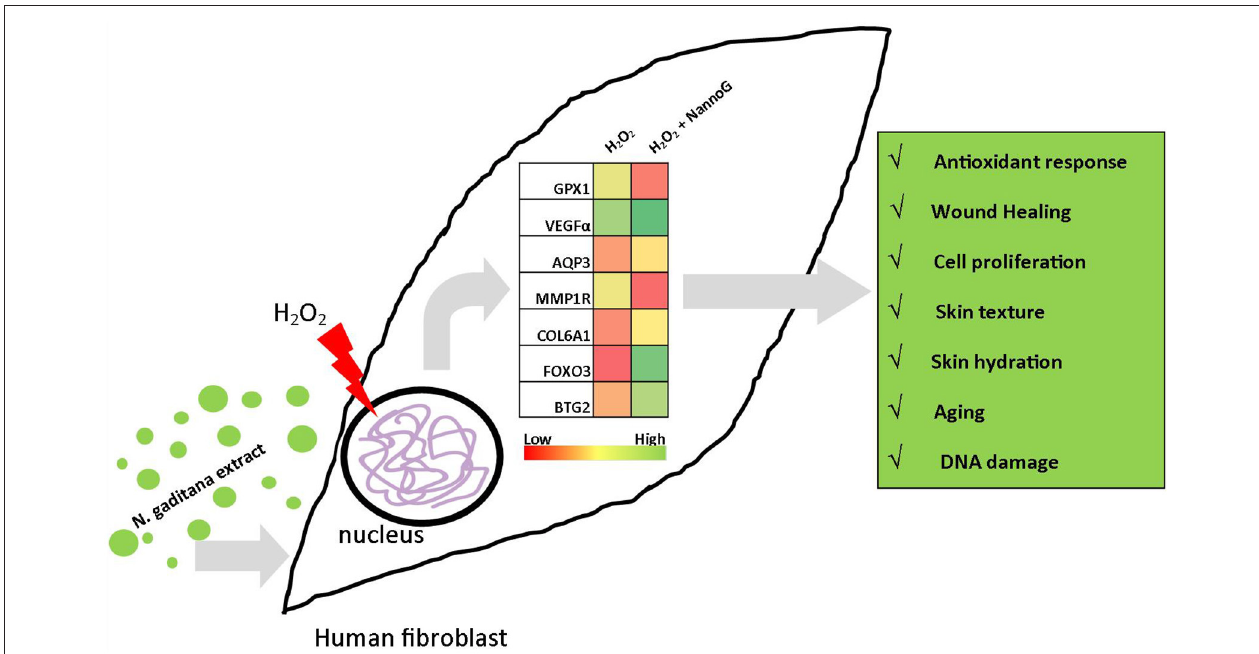
FIGURE 10 | Schematic representation of the major differences observed in gene expression under experimental conditions. Heat charts represents transcript accumulation ratios between H 2 O 2 -stressed fibroblasts pretreated with N. gaditana extract to H 2 O 2 -stressed control